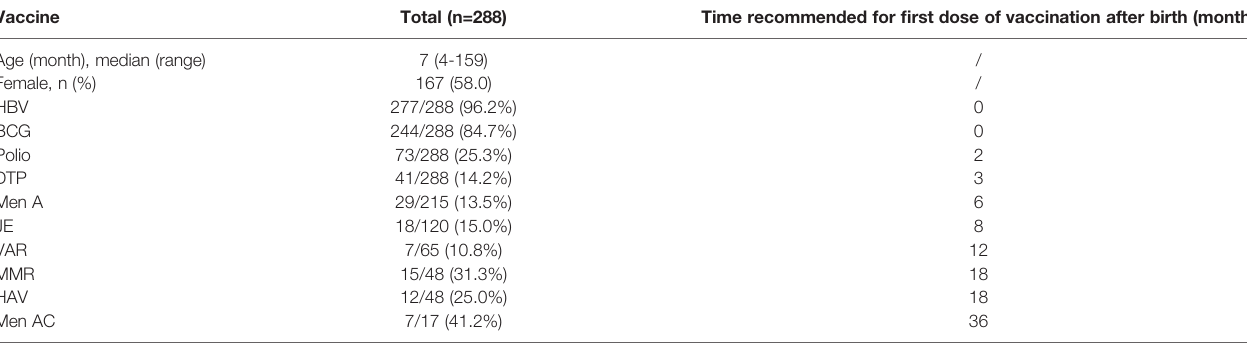
TABLE 1 | The overview of the vaccinations of the enrolled BA patients. Vaccine Total (n=288) Time recommended for fi rst dose of vaccination after birth (month) Age (month), median